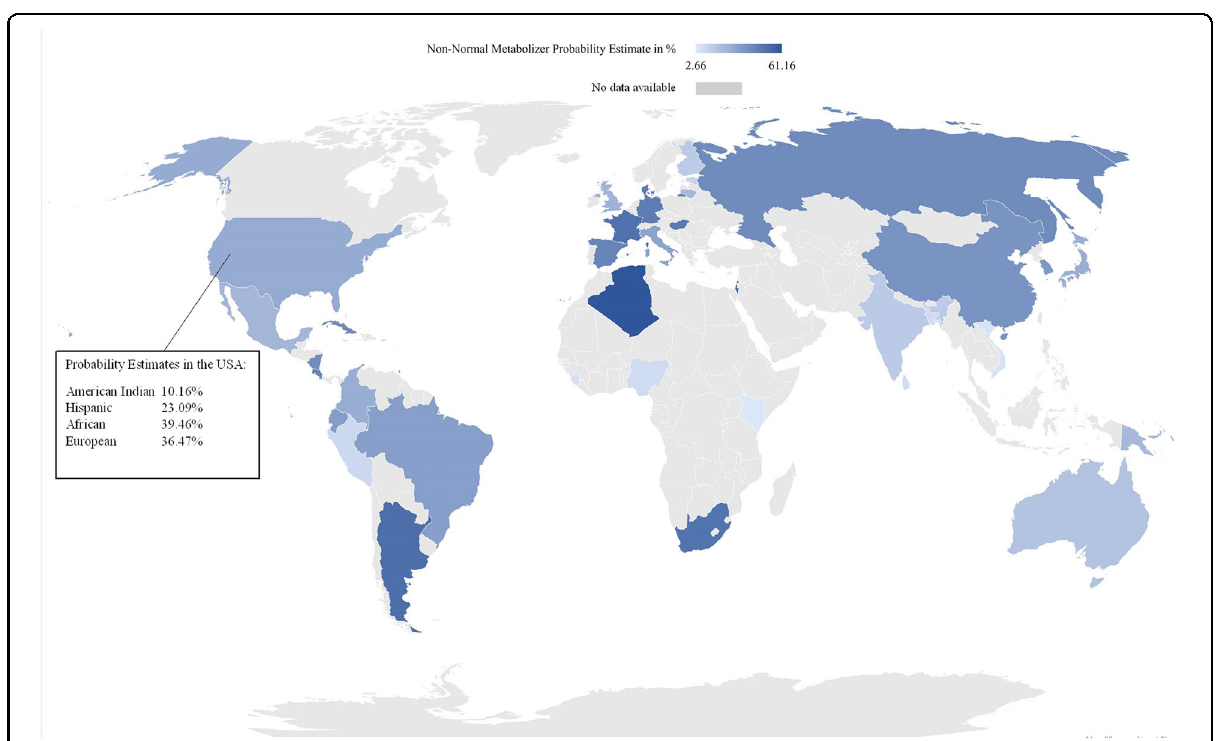
Fig. 3 Worldwide CYP2D6 non-normal metabolizer probability